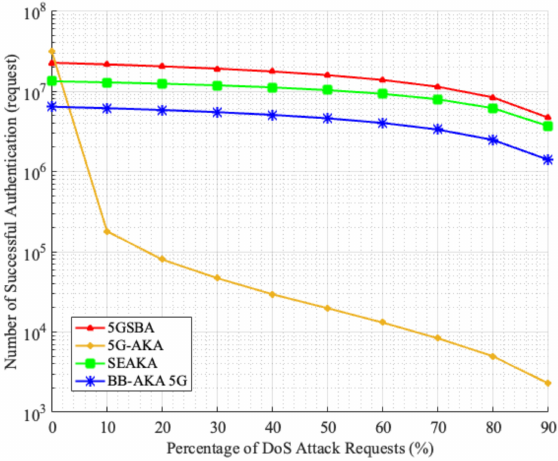
Figure 11. Successful authentications under DoS